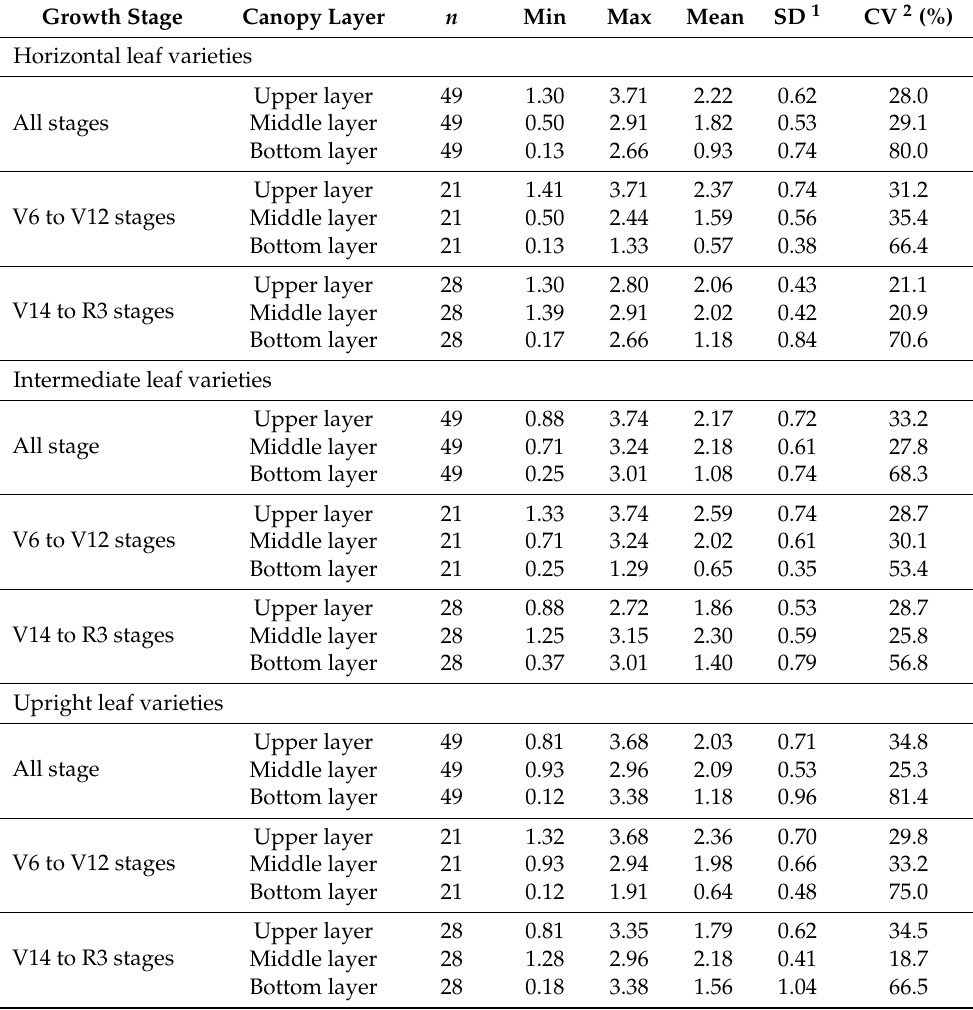
Table 2. Descriptive statistics of the leaf N density (g m − 2 ) in the vertical canopy layers of different maize plant geometry